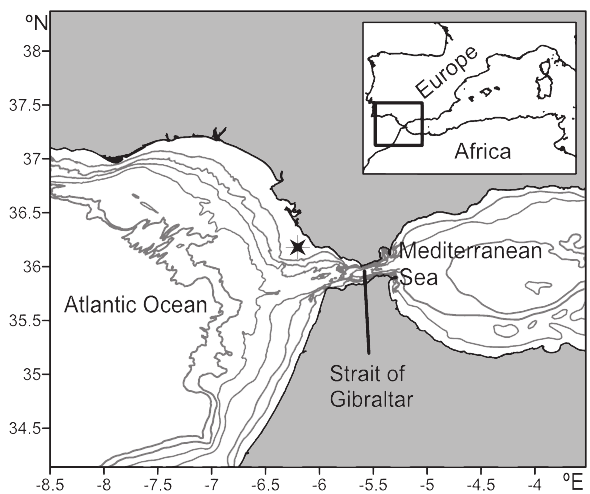
Fig. 1. Map showing the sampling station (black